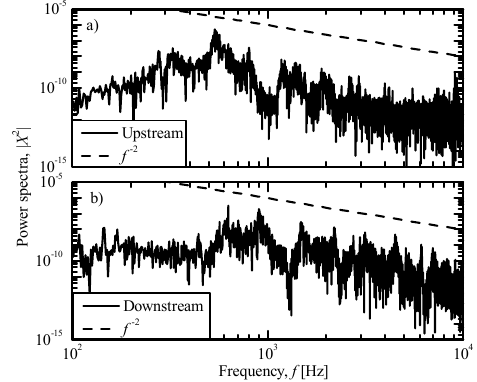
Fig. 10 Behavior of bubble clouds in the intermediate cavitation type.